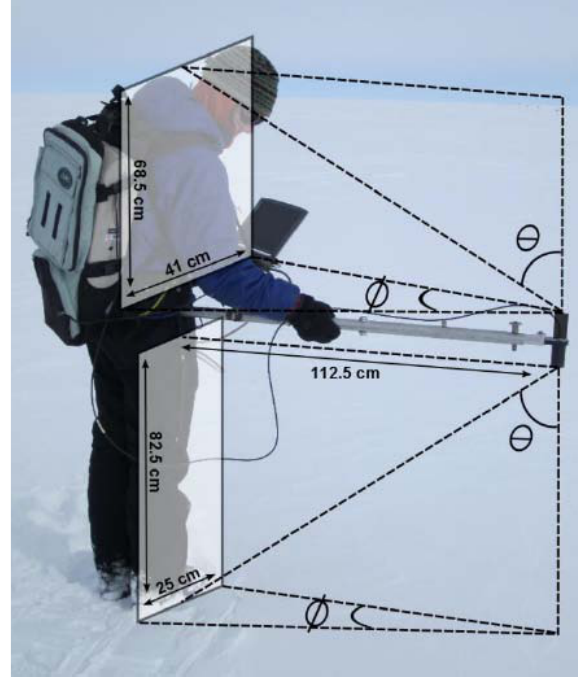
Fig. 2. Set-up of the ASD spectroradiometer during data acquisi- tion. The solid angle viewed by the sensor is corrected through the angles θ and φ , which are used to compute C ↑ and C ↓ to take into account the presence of the